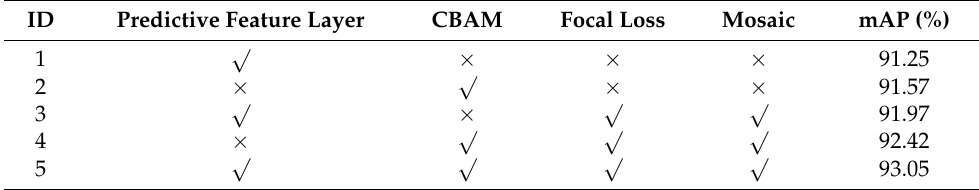
Table 4. Comparison of ablation experiment